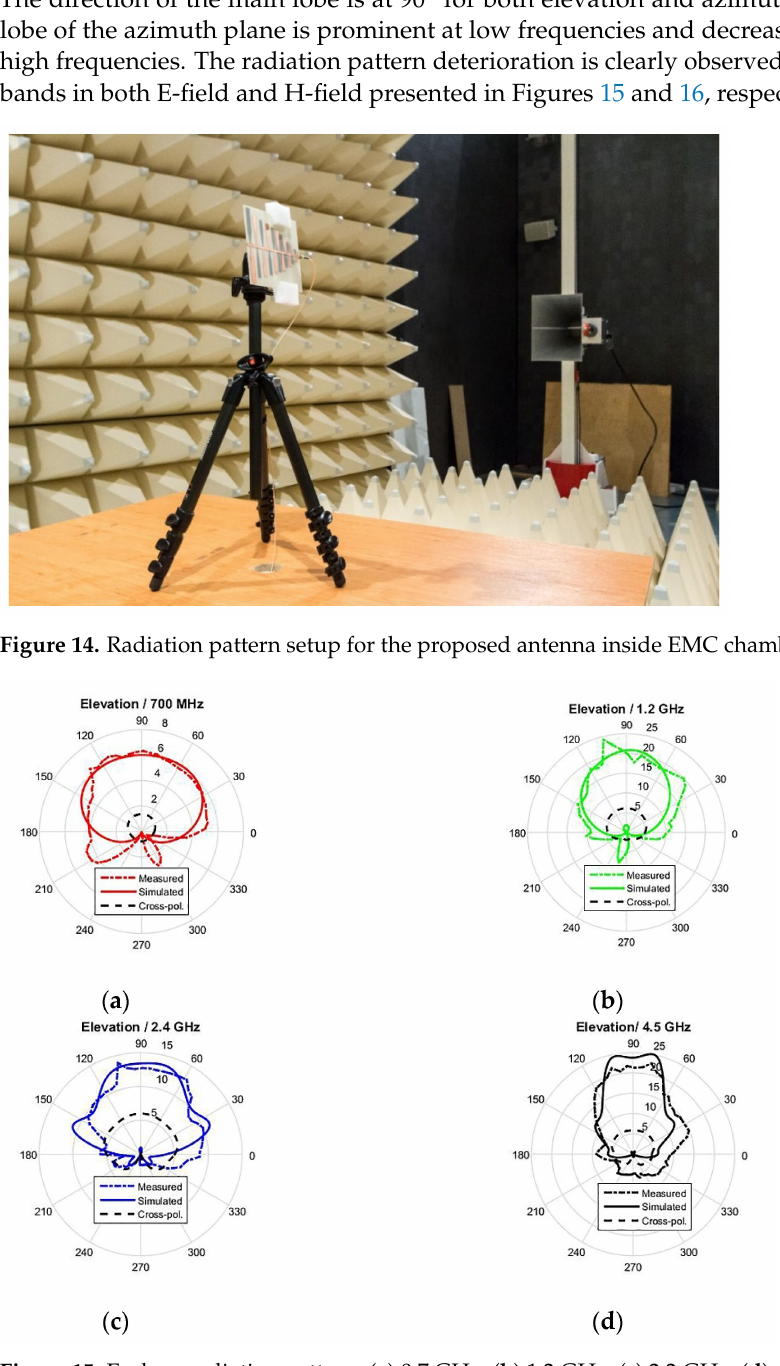
Figure 15. E-plane radiation pattern: ( a ) 0.7 GHz; ( b ) 1.2 GHz; ( c ) 2.2 GHz; ( d ) 4.5